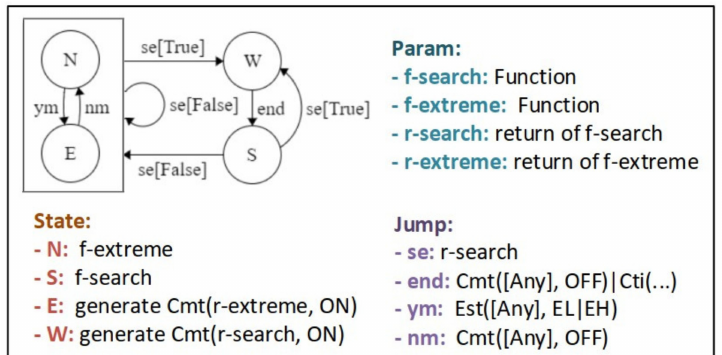
Figure 14. EPA 11.